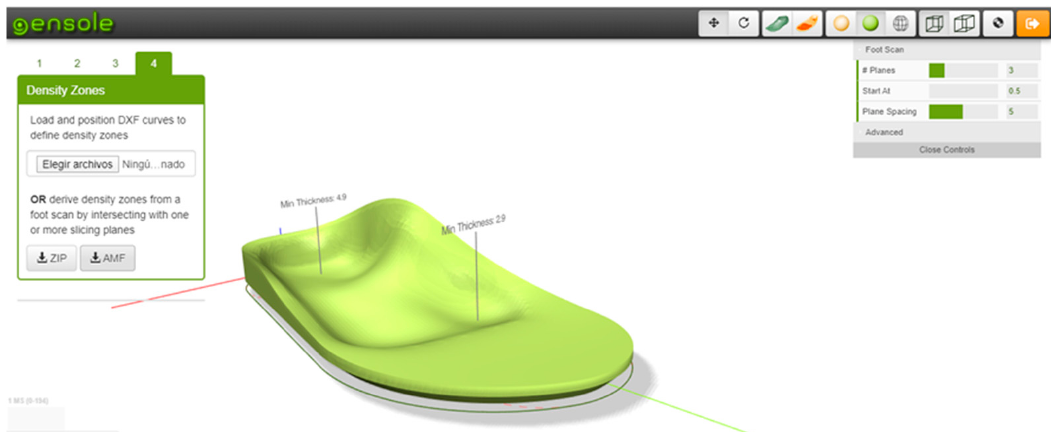
Figure A4. Minimum insole thickness.